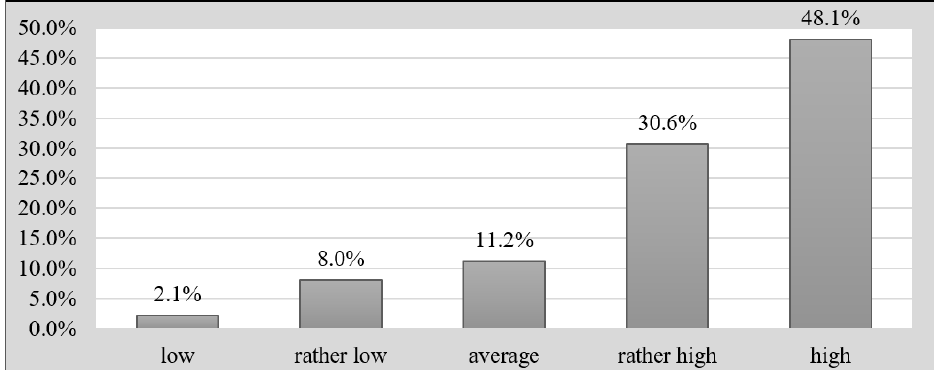
Figure 4. Assessment of religious education (Source: own study).